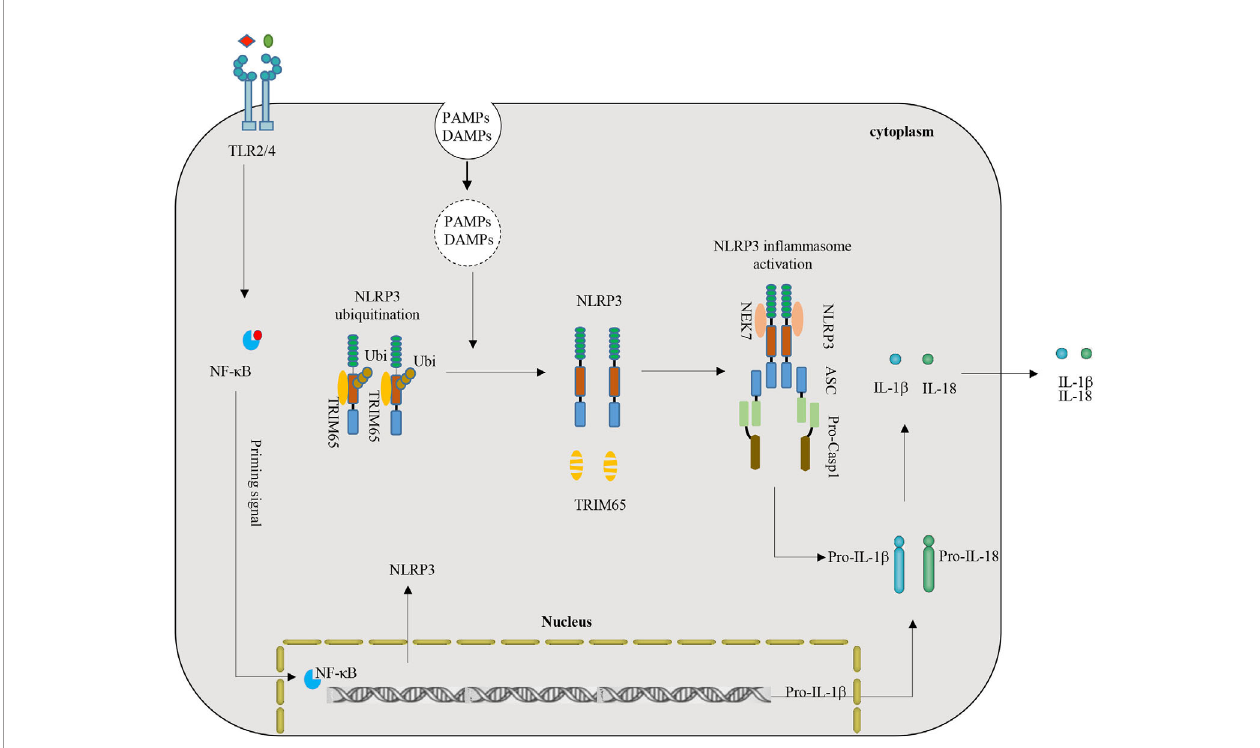
FIGURE 6 | Model of the function and mechanism of TRIM65-mediated inhibition of NLRP3 in fl ammasome activation. TRIM65 directly binds NLRP3 and promotes K48- and K63- linked ubiquitination, which is critical for the inhibition of NLRP3 in fl ammasome activation in resting and priming macrophages. With stimulation of priming signals (for example LPS-TLR4-Myd88-NF- k B) and PAMPs or DAMPs (such as MSU, ATP, R837, Nigericin, etc.), TRIM65 signi fi cantly decreased, follow by attenuated ubiquitination of NLRP3, strengthened NLRP3-NEK7 interaction, assembled and activated NLRP3 in fl ammasome. (PAMPs, pathogen-associated molecular patterns; DAMPs, danger-associated molecular